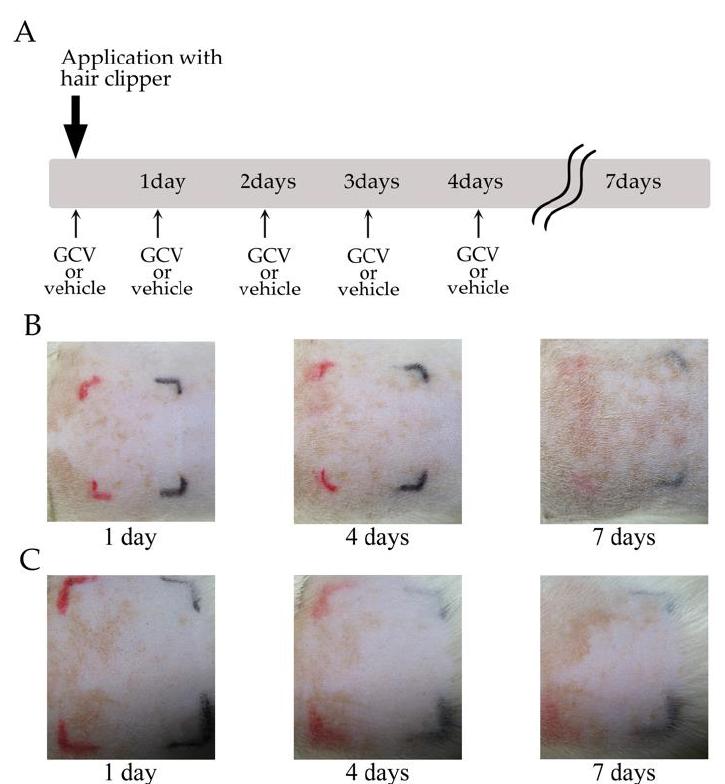
Figure 5. Selective ablation of NG2 + HFSCs during depilation-induced anagen did not induce symptoms of allergic contact dermatitis without application of depilatory cream. ( A ) Schematic of the experimental protocol. The bold arrow indicates depilation with a hair clipper. Arrows show application of GCV or vehicle to defined area (black lines) of the Tg rat skin. GCV, ganciclovir. ( B , C ) Photographs of GCV-applied ( B ) and vehicle-treated ( C ) skin of Tg rats at 1, 4, and 7 days. 2.4. Selective Ablation of NG2 + HFSCs during Anagen Exacerbated the Sensitization Phase of